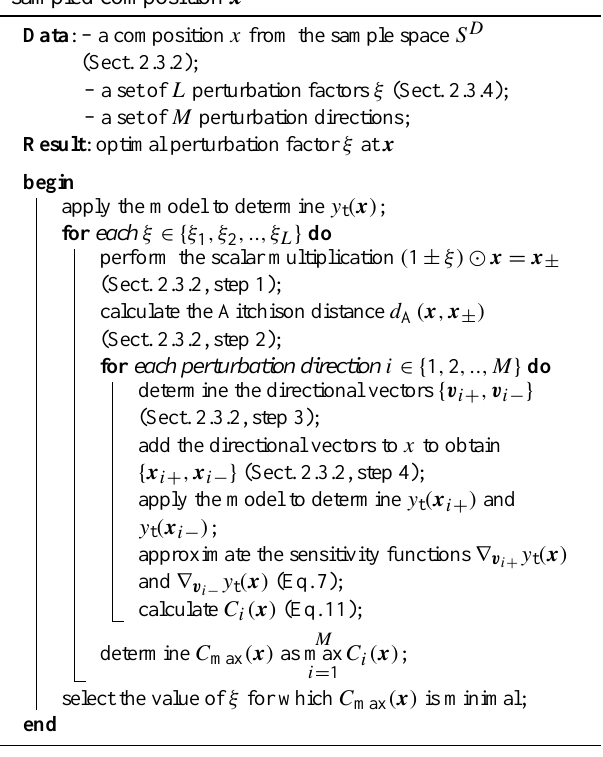
Algorithm 2 : Optimise the perturbation factor ξ for a sampled composition